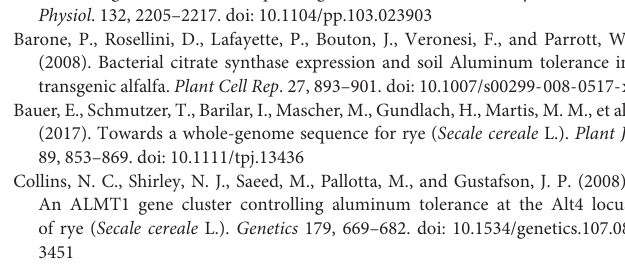
Supplementary Figure 1 | On the left, the hypothetical ScCS protein secondary structure was obtained with PSIPRED v3.0 (http://bioinf.cs.ucl.ac.uk/psipred/). The secondary structure is made up of 23 α -helix regions and 3 β -sheet regions. On the right, the hypothetical tertiary structure of ScCS from the cultivars Ailés and Petkus. The tertiary structure was obtained with the SWISS-MODEL program. The protein from the Protein DataBase (PDB) showed that the greatest similarity to ours (83.3%) was from Arabidopsis thaliana (with a resolution of 2.00 Å). Supplementary Figure 2 | The dendrogram was obtained from the sequences of amino acids of the hypothetical ScCS4 protein and CS proteins of various species of Poaceae and other eudicots. The studied sequences of proteins were extracted from NCBI and Phytozome. Bootstraps with 10,000 replicates were calculated to test the robustness of the dendrogram. Secale cereale L. is in red color, the blue lines indicate the Poaceae species, and the red lines indicate some eudicot species. Supplementary Data 1 | Alignment of ScCS4 cDNA sequences corresponding to eight different sequences (different clones) of S. cereale , one from cv. Ailés, four from cv. Imperial, two from cv. Petkus, and the last from inbred line Riodeva. Supplementary Data 1A | Alignment of ScCS4 amino acid sequences corresponding to eight different sequences (different clones) of S. cereale , one from cv. Ailés, four from cv. Imperial, two from cv. Petkus, and the last from inbred line Riodeva. Supplementary Data 2 | Alignment of ScCS4 cDNA sequence corresponding to S. cereale cv. Ailés with those found in other six species of Poaceae. Supplementary Data 3 | Alignment of ScCS4 putative protein sequences corresponding to the rye cultivars Ailés, Imperial, and Petkus, and the inbred line Riodeva. Supplementary Data 4 | Alignment of ScCS4 putative protein sequences corresponding to S. cereale cv. Imperial, several Poaceae species,